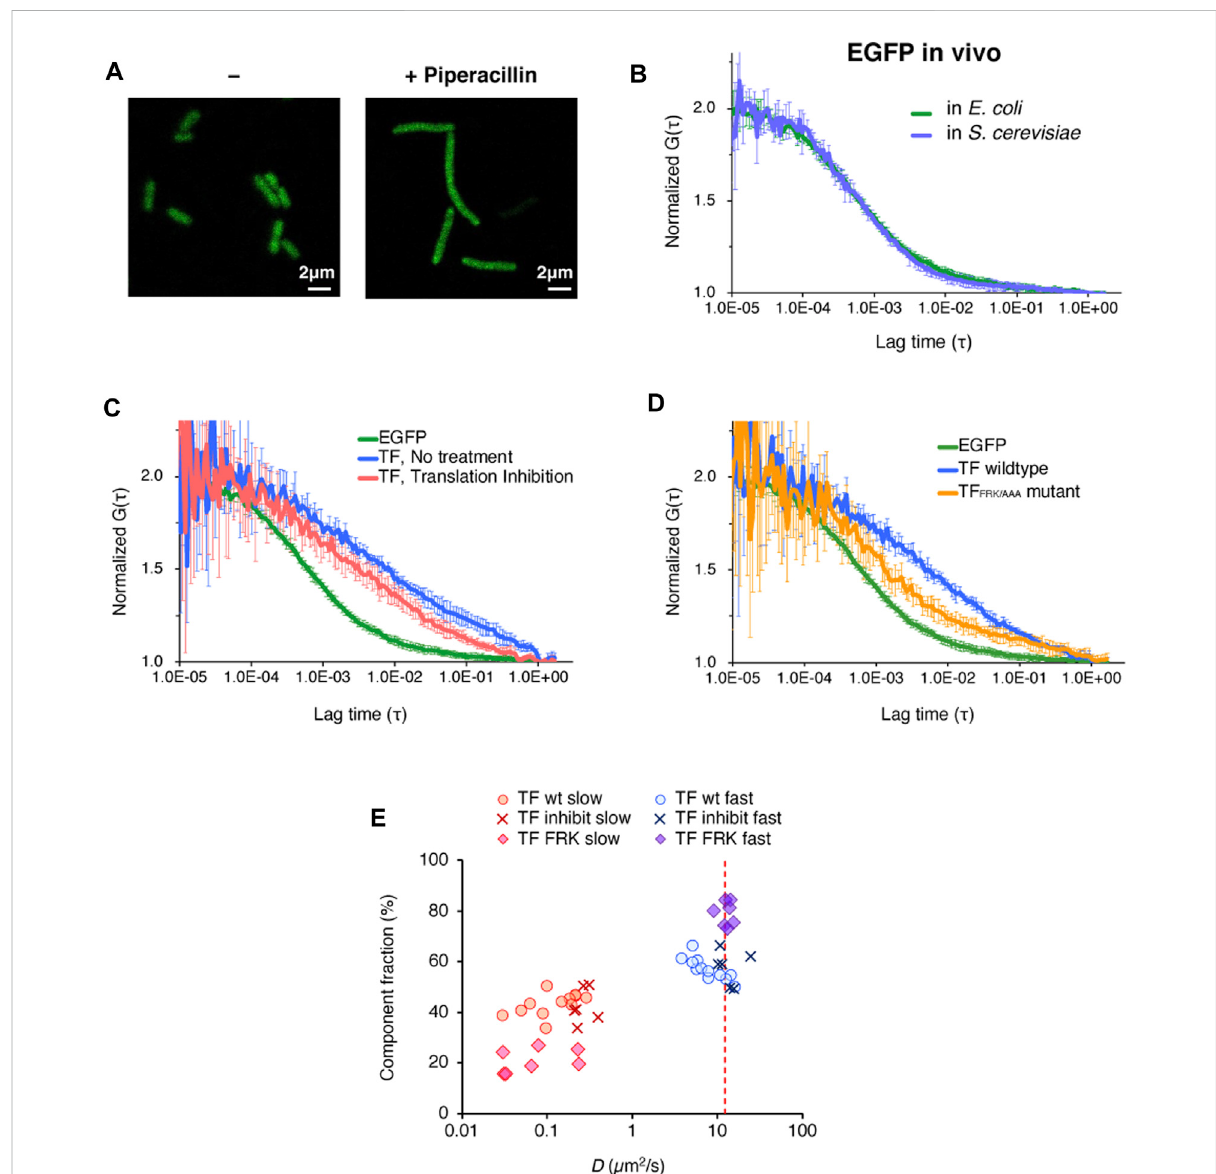
FIGURE 3 In vivo observations of the behavior of TF-EGFP by FCS. (A) Fluorescence image of E. coli cells before and after the piperacillin treatment. This treatment caused the cells to elongate into a fi lamentous shape. Scale bar = 2 µm. (B) Averaged autocorrelation curves of EGFP observed in E. coli cells and S. cerevisiae cells. The number of observed cells was ten for E. coli cells and fi ve for S. cerevisiae cells. Error bars represent standard deviations. (C) Averaged autocorrelation curve of TF-EGFP observed in E. coli cells. For the comparison, the autocorrelation curve of EGFP is shown again (the same as depicted in Figure 3B). Translation inhibition was accomplished by the treatment with a mixture of antibiotics (50 µg/ml kasugamycin, 100 µg/ml erythromycin, and 10 µg/ml puromycin). The number of the observed cells was fi ve for the no treatment condition and six for the translation inhibition condition. Error bars represent standard deviations. (D) Averaged autocorrelation curves of EGFP-fused TF and a TF mutant(TF FRK/AAA )observedin E.coli cells.Forthecomparison,theautocorrelationcurveofEGFPisshownagain(thesameasdepictedinFigure3B). Thenumberofobservedcellswas fi veforthenotreatmentconditionandsevenforthetranslationinhibitioncondition.Errorbarsrepresentstandard deviations. (E) Distribution ofthediffusioncoef fi cientsandthepopulationsofboththefastandslowcomponentsundereachcondition,obtained by two-component fi tting. The red dashed line represents the hypothesized diffusion coef fi cient of TF-EGFP, calculated by its molecular weight (75 kDa), and the diffusion coef fi cient of EGFP in E. coli cells obtained in this